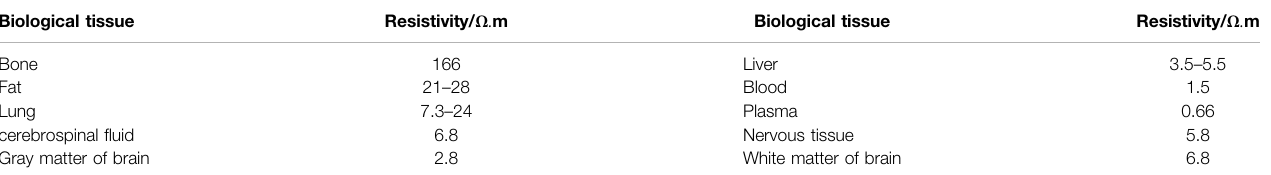
TABLE 1 | Conductivity parameters of human tissues and organs (20 – 100 KHz). Biological tissue Resistivity/ Ω . m